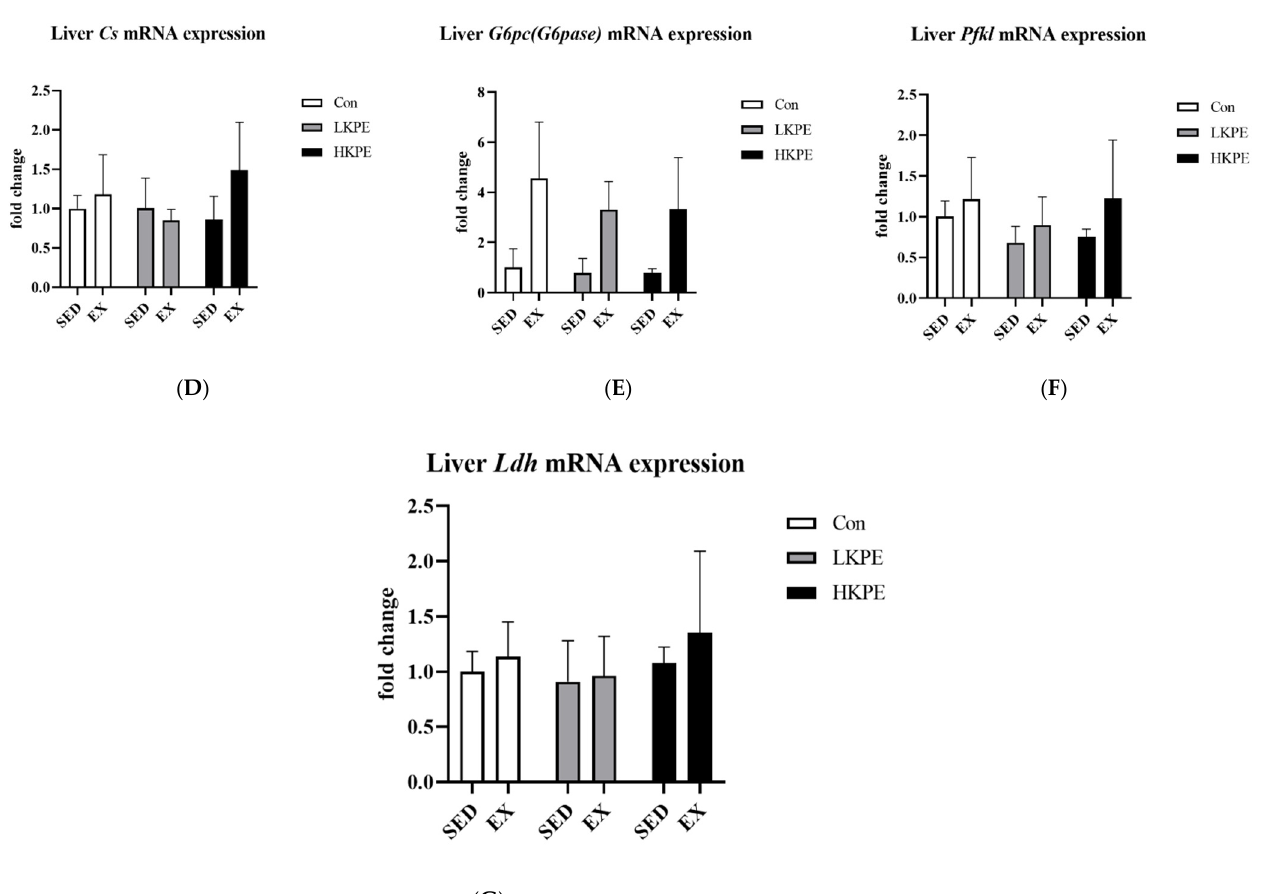
Figure 8. mRNA expression of ( A ) Pck1 (Pepck) , ( B ) Gp , ( C ) Gs , ( D ) Cs , ( E ) G6pc (G6pase) , ( F ) Pfkl , and ( G ) Ldh in liver immediately after exhaustion. G6pc (G6pase) , glucose-6-phosphatase catalytic; Pck1 (Pepck), phosphoenolpyruvate carboxykinase 1 cytosolic; Gs , glycogen synthase; Gp , glycogen phos- phorylase; Pfkl , 6-phosphofructokinase liver type; Gs , citrate synthase; Ldh , lactate dehydrogenase; SED, sedentary; EX, exercise; Con, control; KPE, Kaempferia parviflora administration; ns, no sig- nificance observed; * p < 0.05, ** p < 0.01.